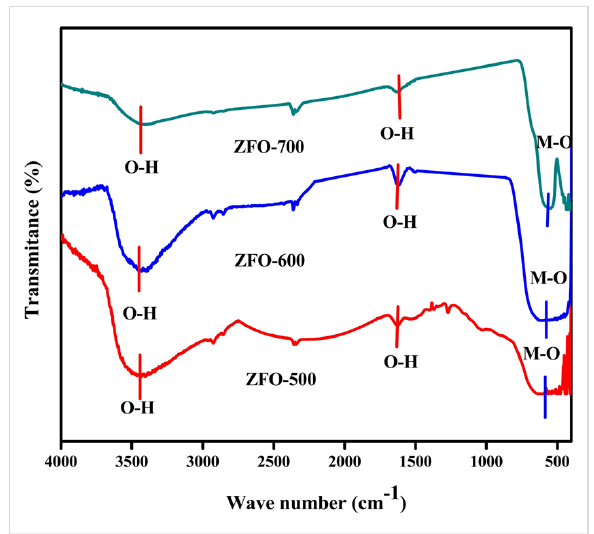
Figure 6: FTIR spectra of ZFO